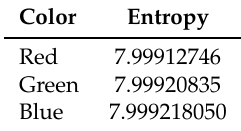
Table 4. Entropy of the Lena RBG cryptogram.